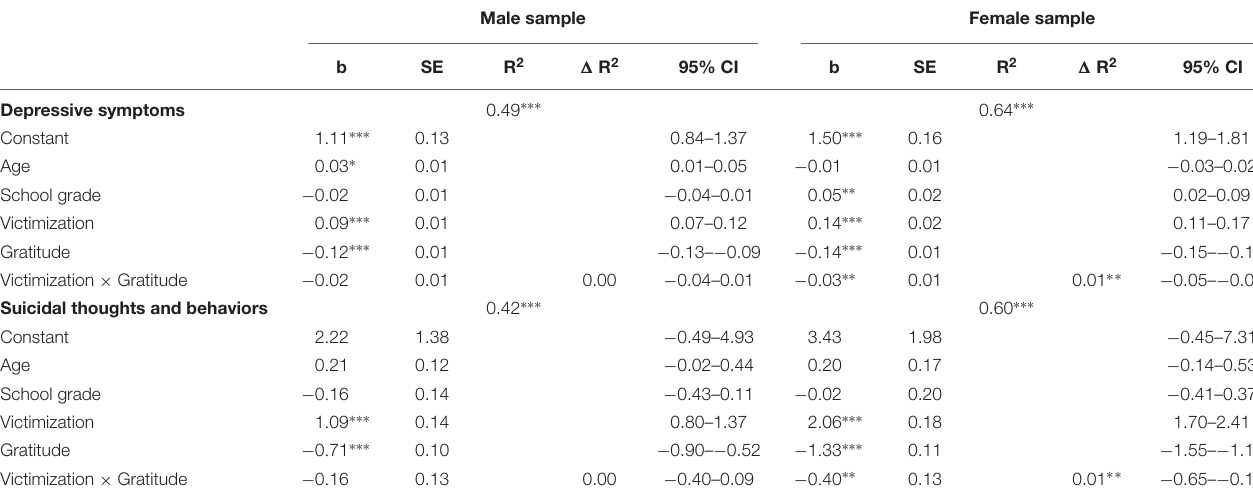
TABLE 4 | Moderating effect of gratitude on suicide risk for the female and male samples.